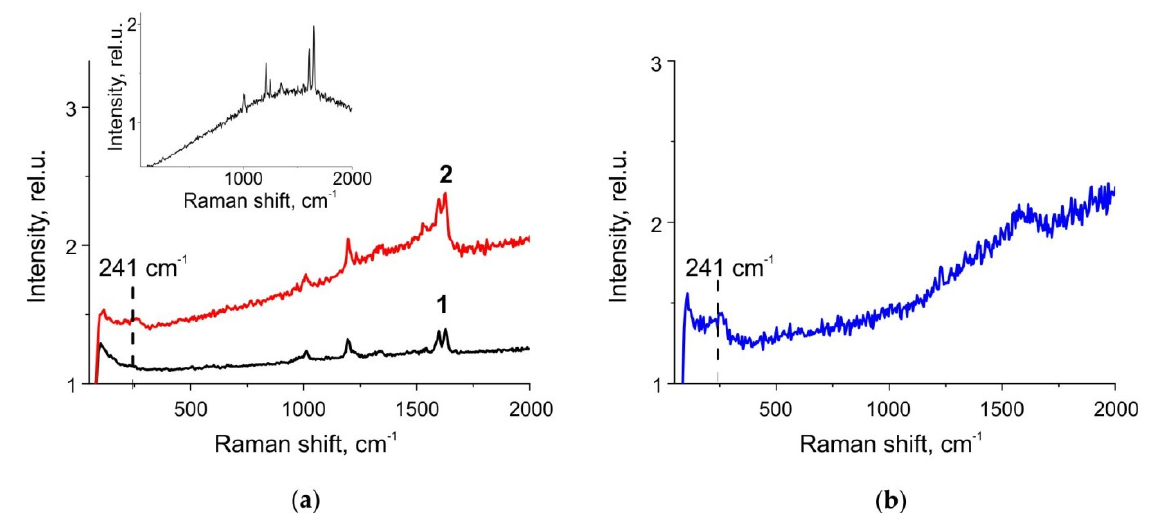
Figure 8. SERS spectra of a monolayer of BPE deposited on a silver nanoisland film before (1) and after (2) exposure to PBS ( a ). The inset: Raman spectrum from BPE crystallites on glass without NPs. Raman spectra of a pristine silver nanoisland film (without BPE) after exposure to PBS ( b ).